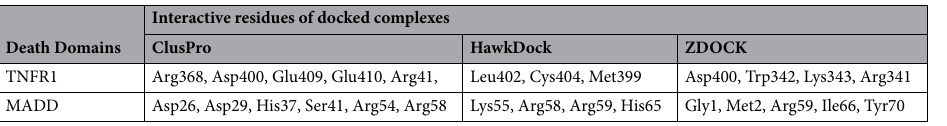
Table 4. Residual analysis using hydrogen